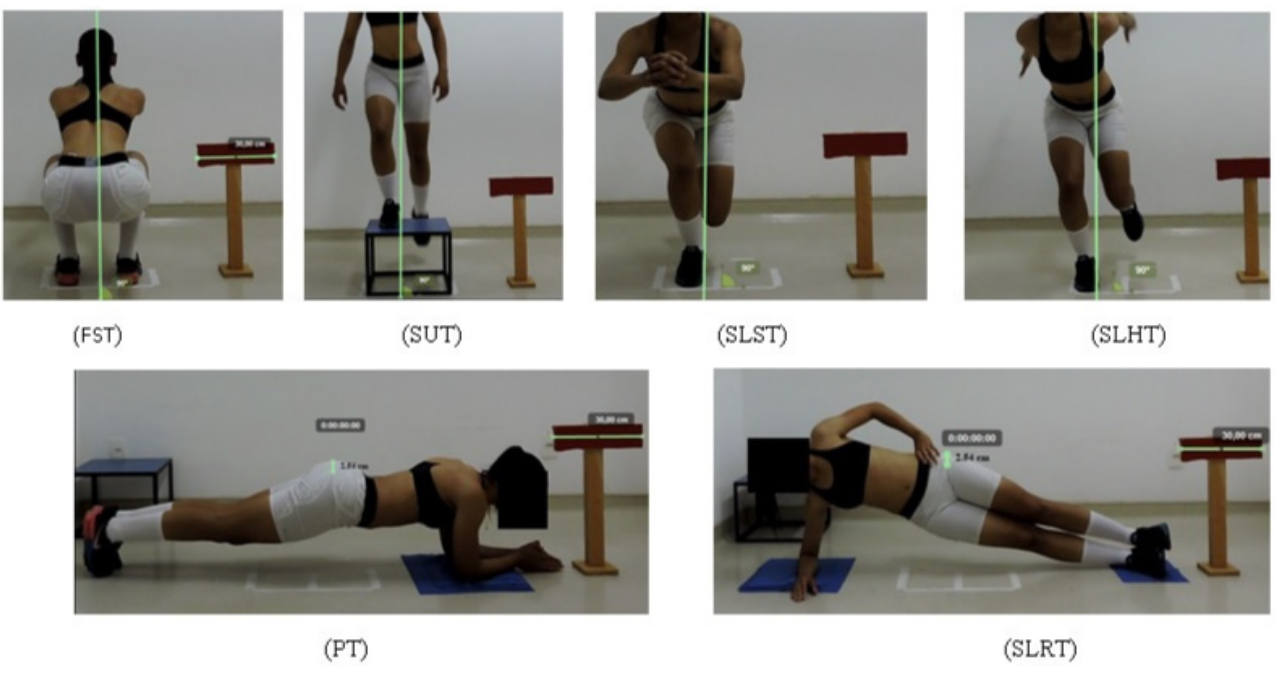
Figure 1 - The protocol of DMA. Full squat test (FST); Step-up test (SUT); Single-leg squat test (SLST); Single leg hop test (SLHT); Plank test (PT); Side plank test (SPRT).